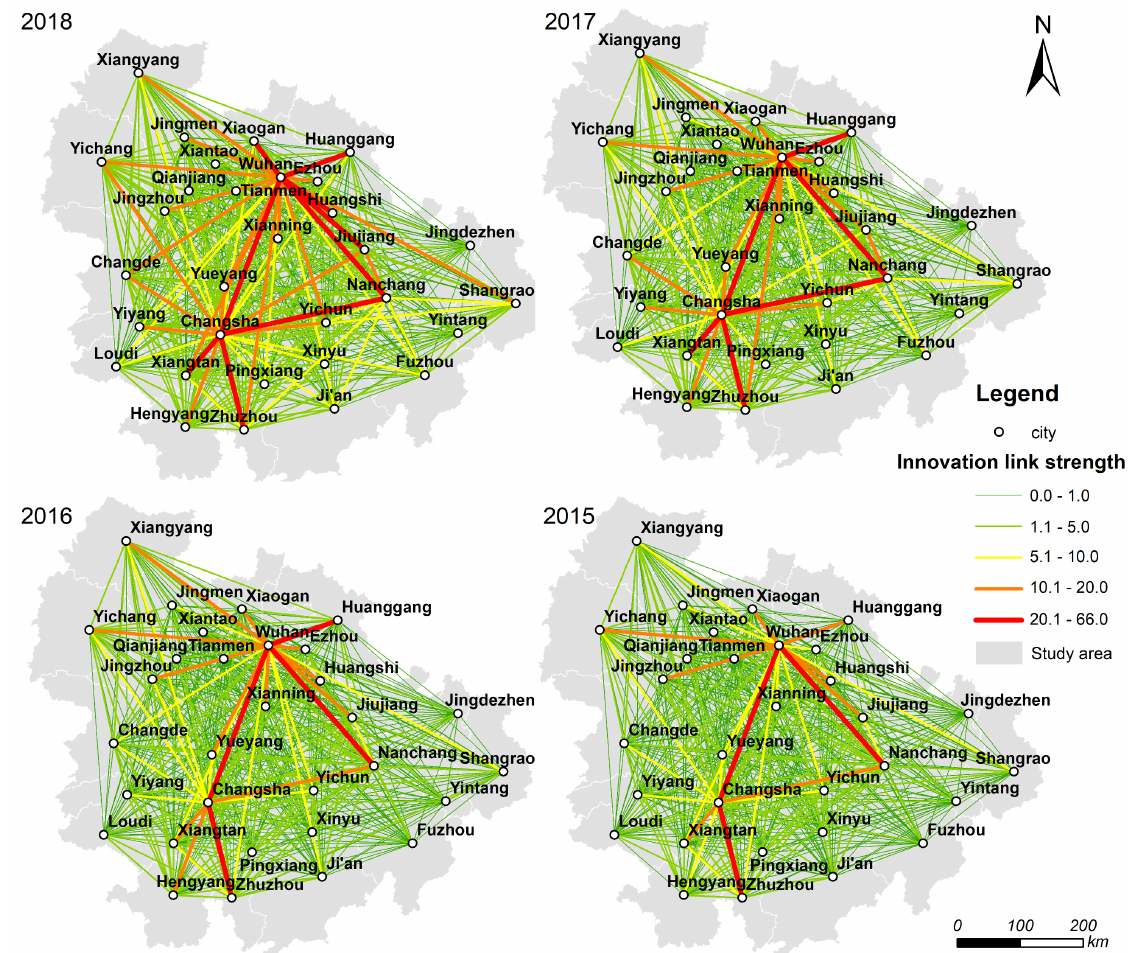
Figure 4. Evolution of the hierarchical structure of innovation networks in the UAMRYR.